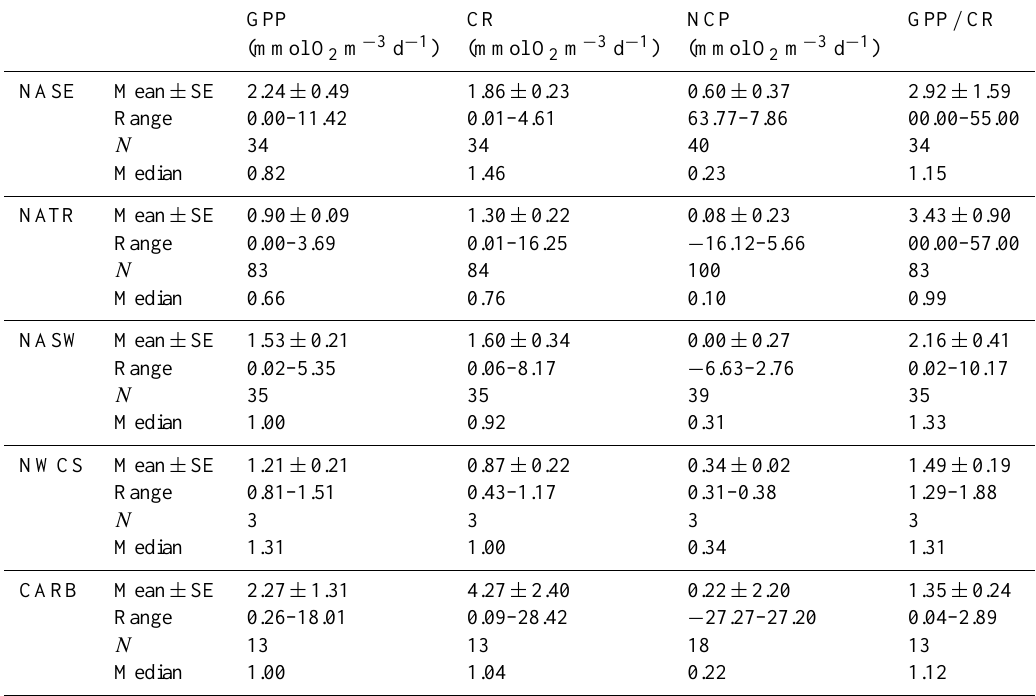
Table 3. Mean ( ± SE), range, number of observations ( N ) and median of metabolic rates (GPP, CR, NCP) and GPP / CR ratio for the Longhurst biogeochemical provinces crossed in the study